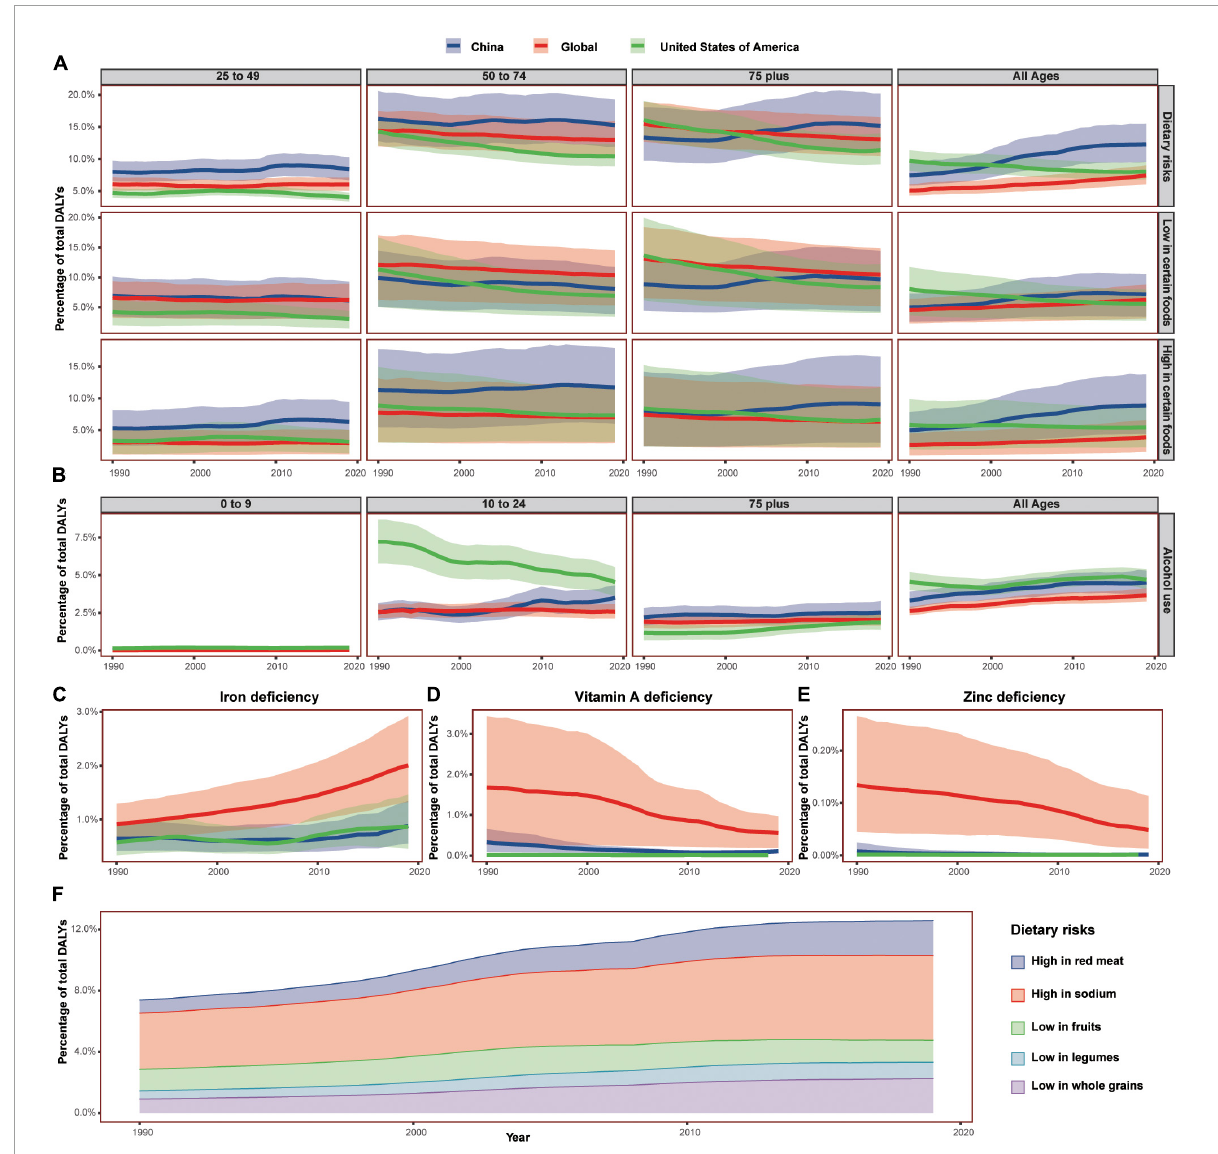
FIGURE6 The DALYs induced by diet-related factors in China, the United States of America, and the world in 1990–2019. (A) Showed the DALYs induced by total dietary risks, diet high in certain foods, and diet low in certain foods by age group. (B) Showed the DALYs induced by alcohol use by age group. (C–E) Showed the DALYs of 0–9 age group induced by deficiencies of iron, vitamin A, and zine C, respectively. (F) Showed the trend of DALYs induced by top 5 dietary risks in China. Shaded sections indicate 95% uncertainty intervals. DALYs, disability-adjusted